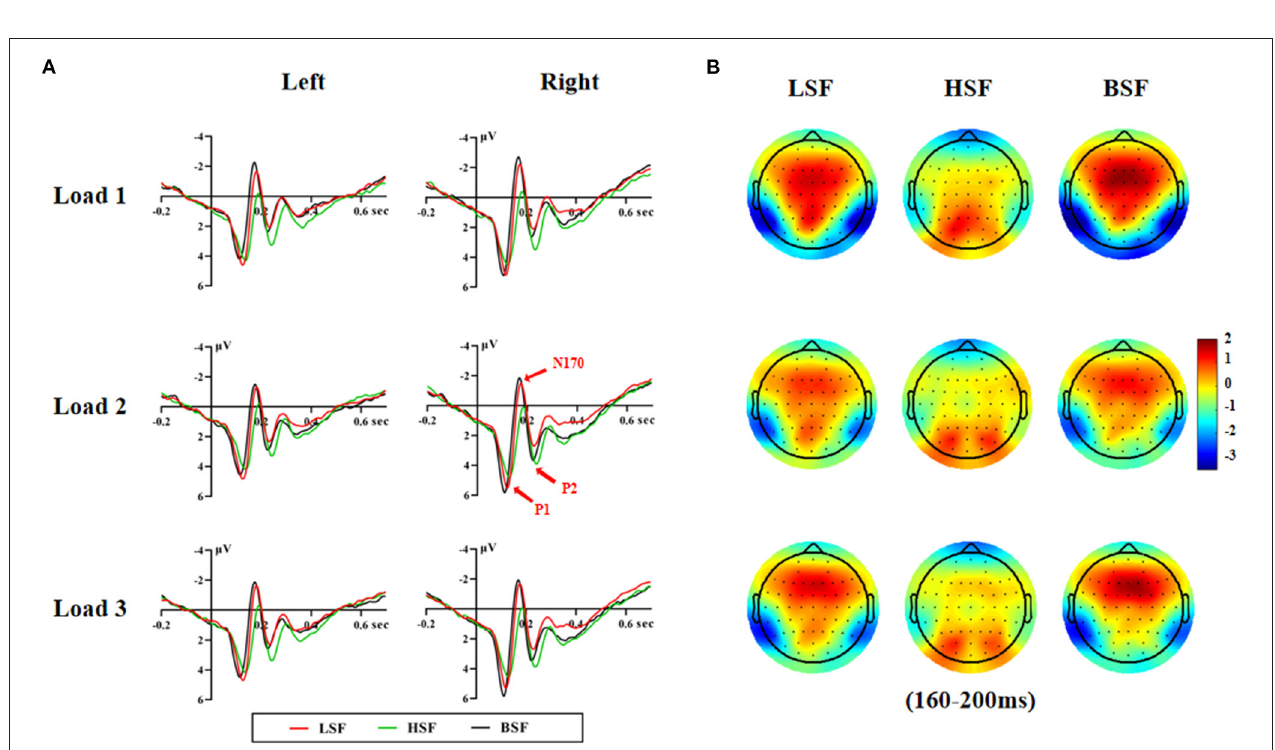
FIGURE 3 | Grand averaged ERP waveforms on the left and right hemispheres (A) and the topographic maps (B) during the retrieval stage.